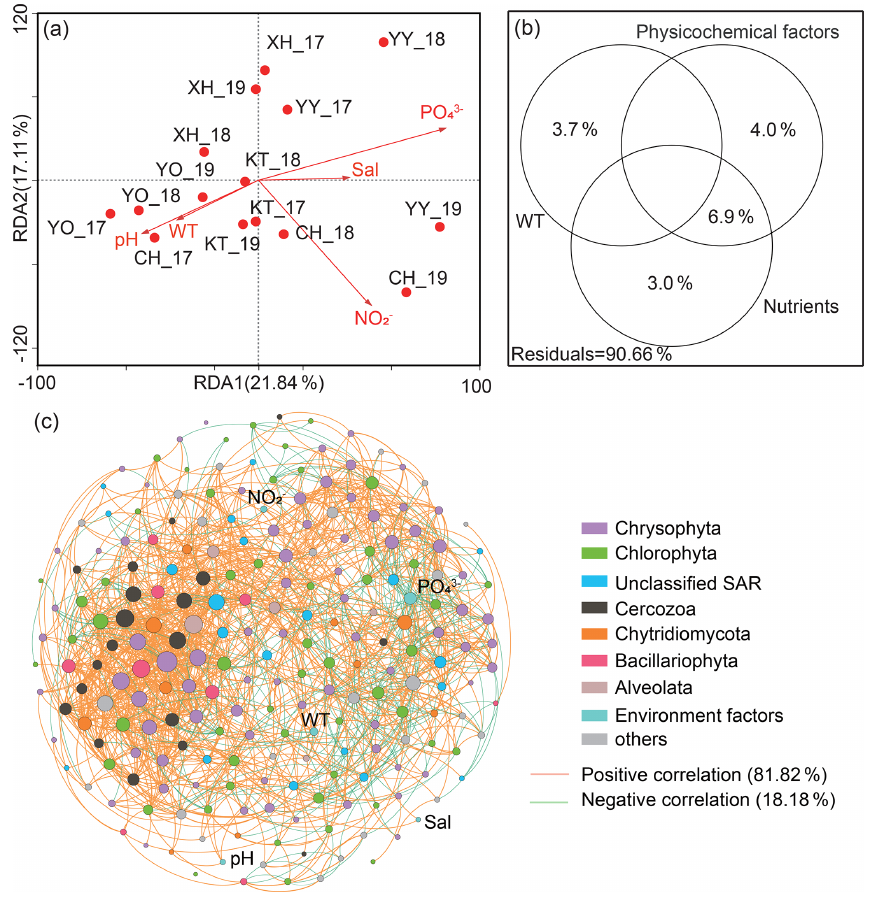
Figure 5. Effect of environmental variables on microbial eukaryotic communities and co-occurrence pattern. (a) Canonical correlation analysis plots and (b) variance partitioning analysis. Sal: salinity; WT: water temperature; NO − work analysis revealing the interspecies associations between microbial eukaryotic operational taxonomic units (OTUs) and the correlation between environmental factors and OTUs in the lakes’ integrated networks. The size of each OTUs or environmental factor (node) is propor- tional to the degree centrality. Others: other phyla and unclassified